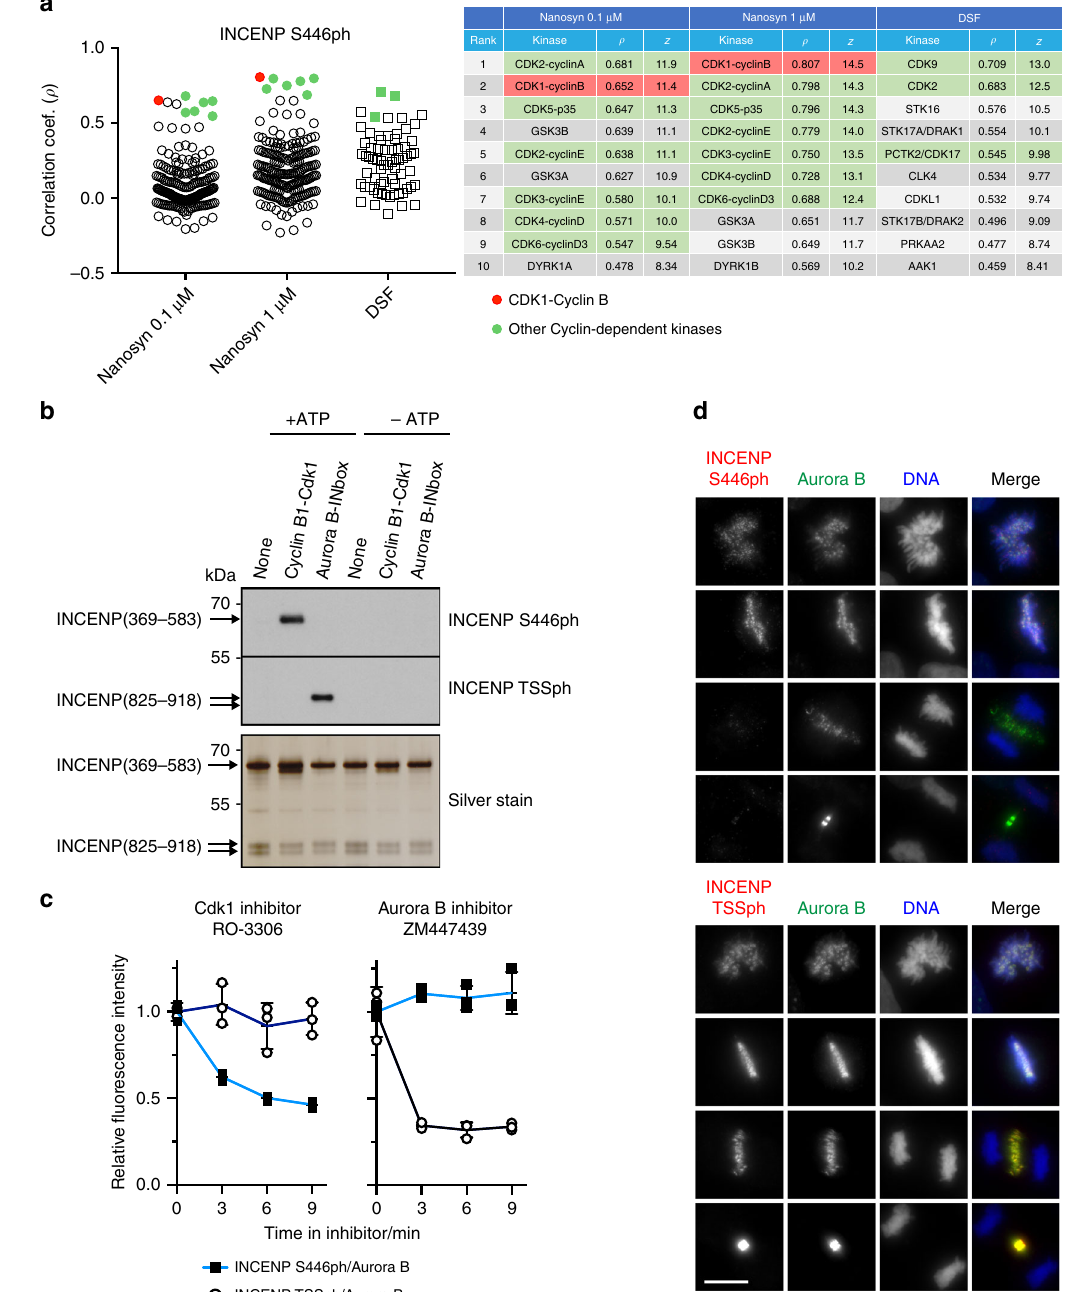
Fig. 4 Results of a KiPIK screen for INCENP S446ph, and con fi rmatory experiments. a The stripcharts on the left show the Pearson correlation coef fi cients with each kinase in the Nanosyn pro fi ling datasets at 0.1 and 1 µ M, and the DSF pro fi ling dataset. The table on the right shows the top 10 hits from each pro fi ling dataset with corresponding correlation coef fi cients and z -scores. The overall top hit kinase is shown in red, and closely related kinases in green. Note that Cdk1 is not present in the DSF dataset. b Recombinant Cyclin B-Cdk1 ef fi ciently phosphorylates INCENP S446, but not INCENP TSS, in vitro. Recombinant INCENP(369 – 583) and INCENP(825 – 918) were provided as potential substrates for GST-CDK1/GST-CycB or Aurora B/INbox and phosphorylation was detected using the corresponding phosphospeci fi c antibodies. The experiment was done twice with similar results. c Acute inhibition of Cdk1, but not Aurora B, lowers INCENP S446ph (black squares) but not INCENP TSSph (open circles) in mitotic HeLa cells. In contrast, acute inhibition of Aurora B lowers INCENP TSSph, but not S446ph. The y -axis shows the ratio of INCENP phosphorylation/Aurora B intensity on chromatin. Only cells in which Aurora B was on chromatin were analyzed. Error bars show means ± SD ( n = 3 separate cell cultures treated in parallel). d Immuno fl uorescence microscopy of INCENP S446ph and INCENP TSSph in mitotic HeLa cells. Both INCENP S446ph and TSSph are phosphorylated in early mitosis but, after INCENP and Aurora B move to the spindle midzone in anaphase cells, INCENP is phosphorylated at the TSSph Aurora B target residues but not at the Cdk1 target S446ph. Scale bar is 10 µ m. The experiment was done twice with similar results. Source data are provided as a Source Data fi